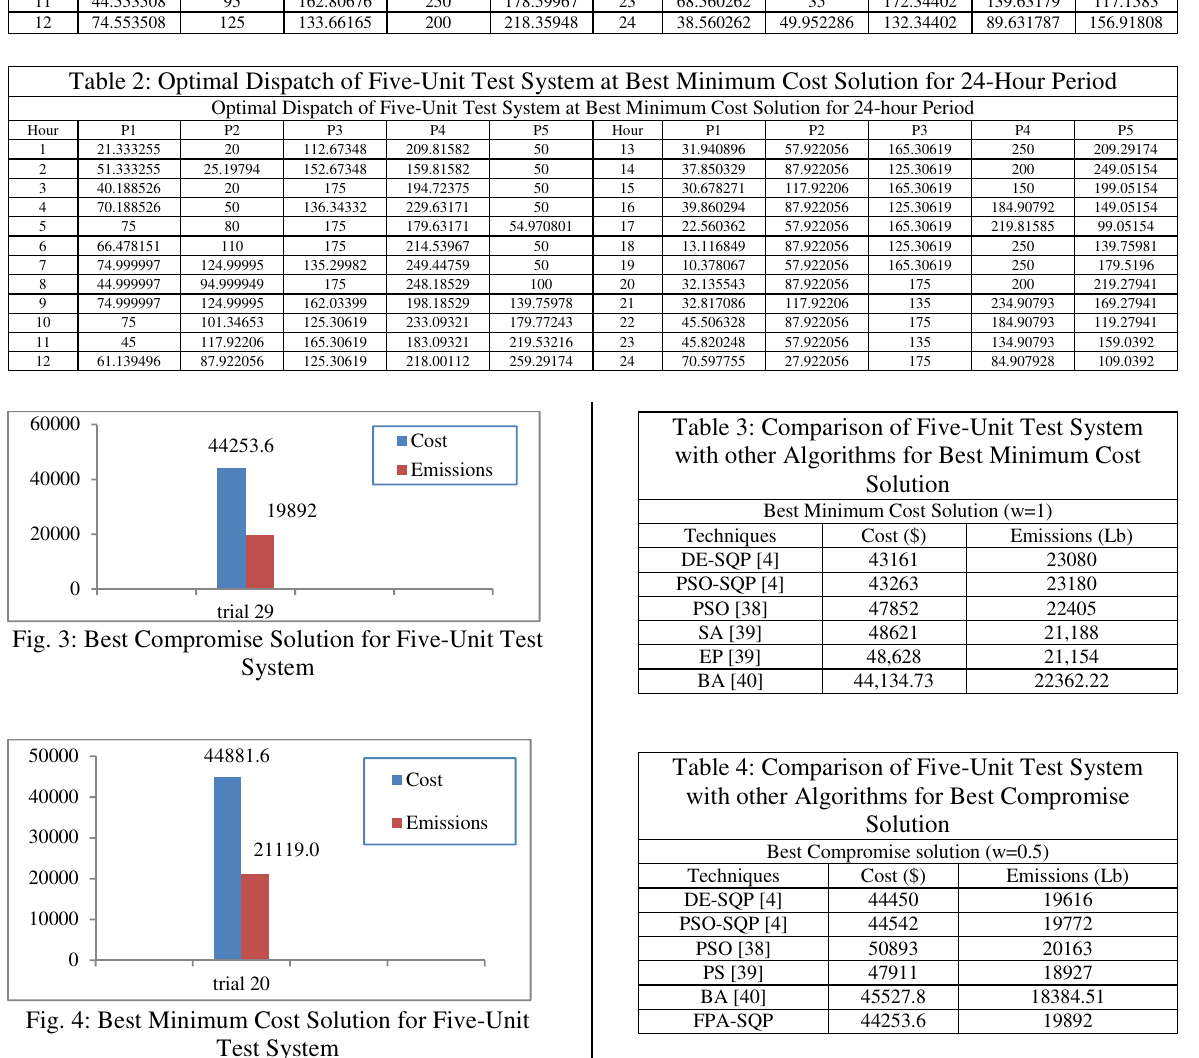
Table 2: Optimal Dispatch of Five-Unit Test System at Best Minimum Cost Solution for 24-Hour Period